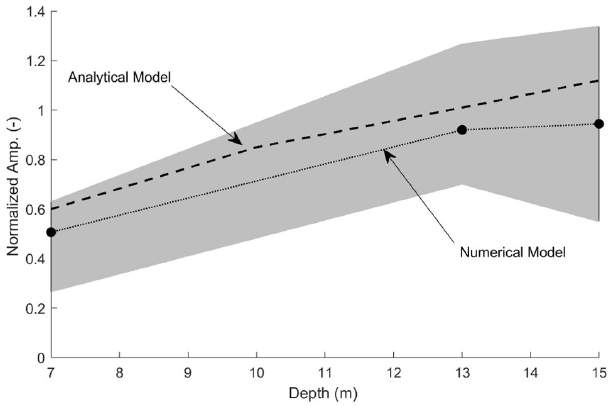
Figure 5. Comparison of normalized surge amplitude as a function of depth for an estuary resembling the Cape Fear Estuary at an in- land location at the approximate location of Wilmington, North Car- olina. The dashed line is the analytical model result, and the solid line is the numerical result. The idealized numerical model uses a surge event with a mean amplitude of 0.6m at the ocean bound- ary (data from Familkhalili and Talke, 2016). The fill area is the range of results due to different relative phase of the storm surge and tide wave. The “analytical model” results are for a 12h surge that had an amplitude of 0.5m and is evaluated at L ∗ = 1 . 5, i.e., at approximately same location as the numerical model. The y axis is normalized surge amplitude and equals 1 at the ocean